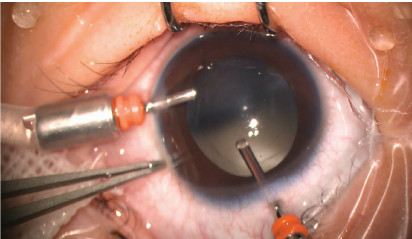
Figure 2: Intraoperative video frame shows the operated eye of the limbal group after anterior capsulotomy, after lensectomy, after posterior capsulotomy, and during anterior